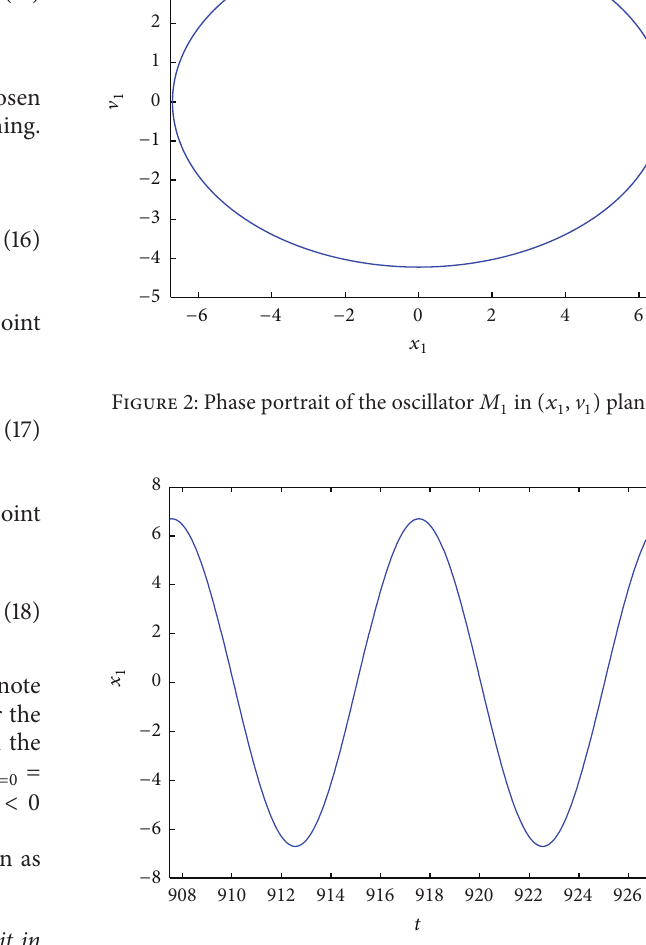
Figure 3: Time history of the displacement of the oscillator 𝑀 1 .